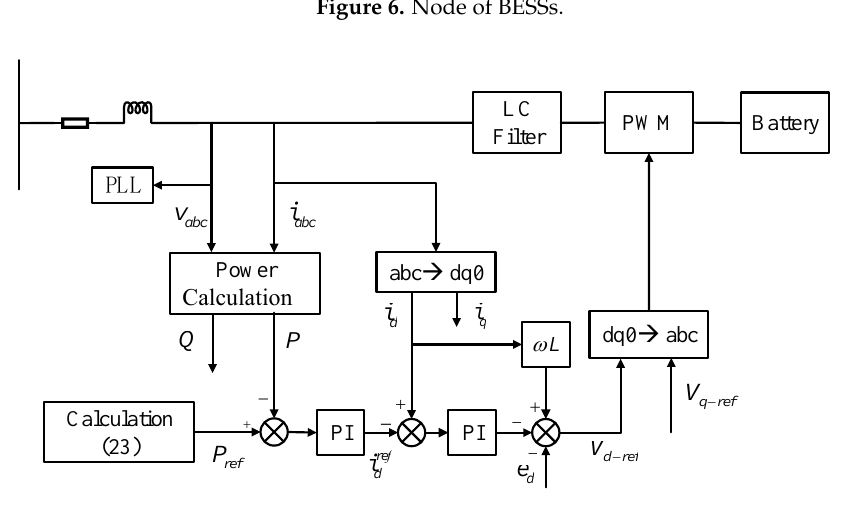
Figure 7. Power control block of BESS.